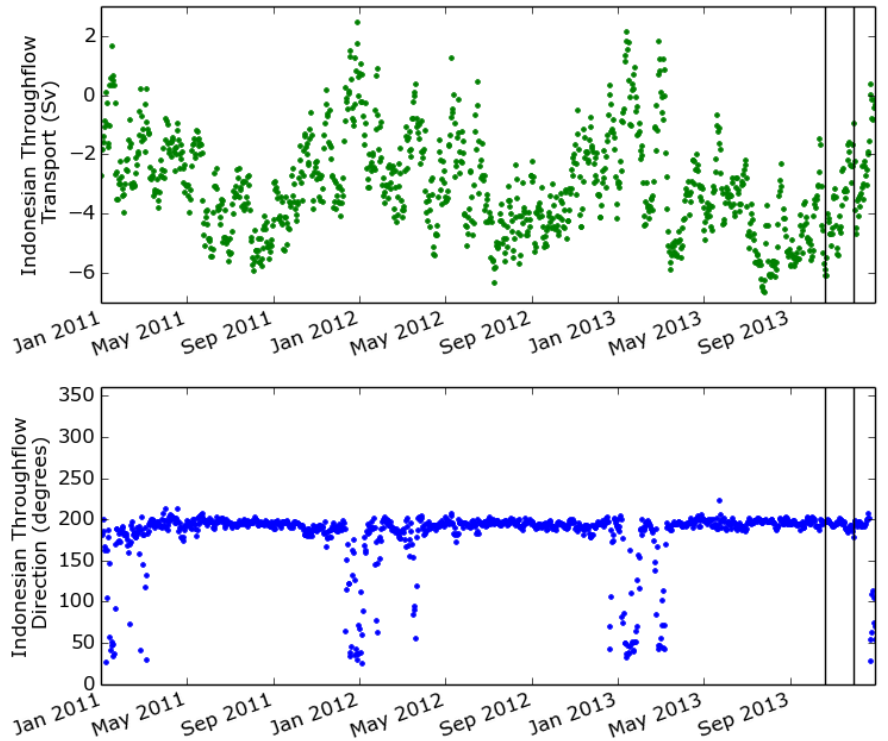
Figure 6. Time variation of the Indonesian Through flow in the Lombok Strait, as diagnosed from the HYCOM model. The vertical lines mark the times used to capture strong (first line) and weak (second line) ITF conditions. Flow units are Sverdrups (Sv) which is 106 cubic metres per second. Note, when Sv is negative it is flowing towards the south.